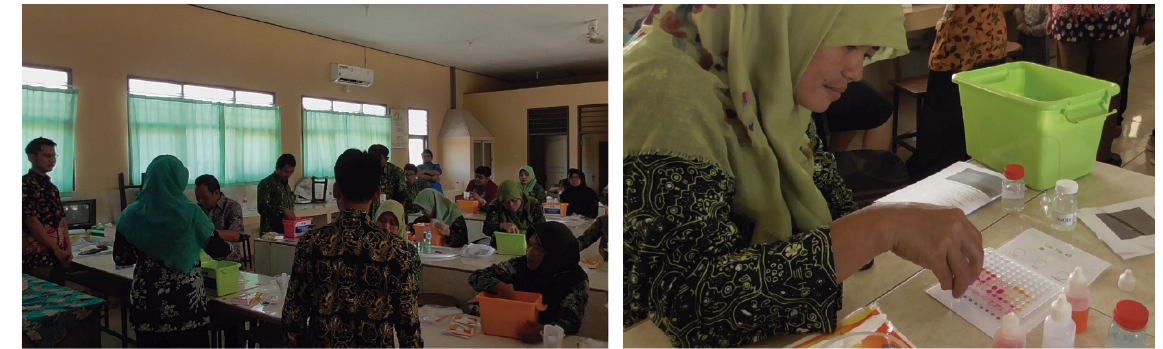
Figure 6. Workshop activities in the working group of chemistry subject